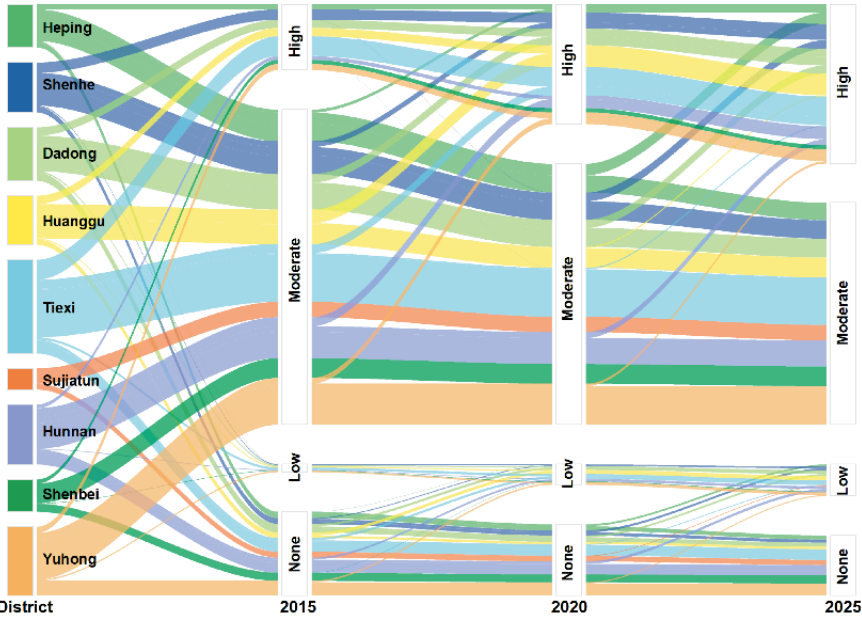
Figure 5. Spatial changes in residential zones with quantity accessibility ranking.